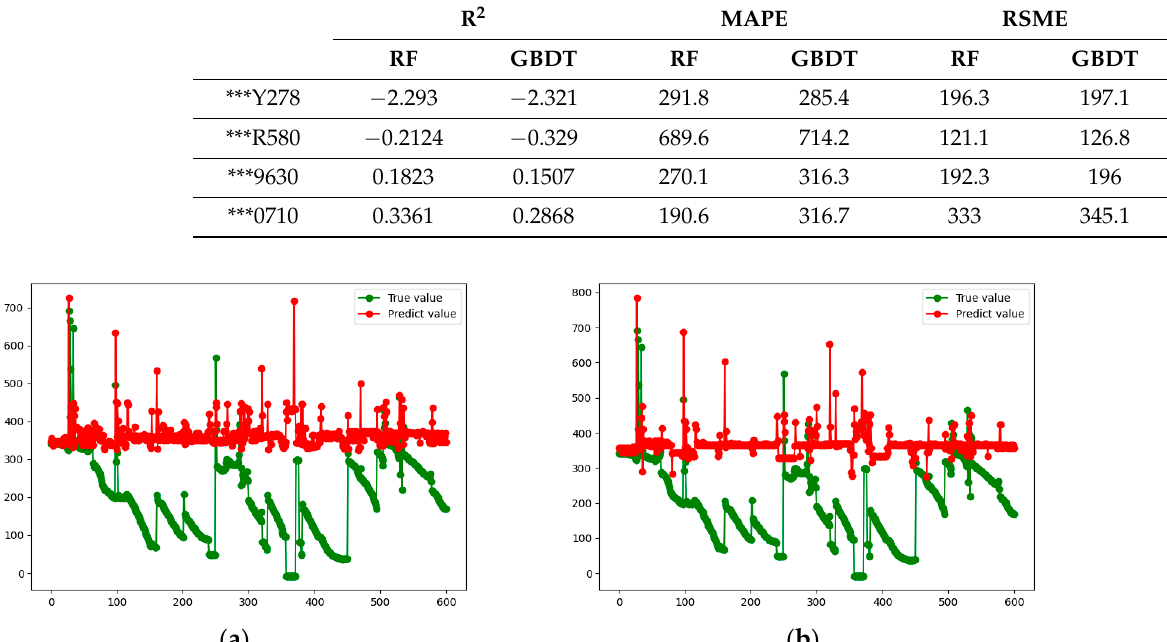
( b ) Figure 10. The prediction results by RF ( a ) and GBDT ( b ) for the vehicle of ***9630. ( a ) ( b ) Figure 11. The prediction results by RF ( a ) and GBDT ( b ) for the vehicle of ***0710.